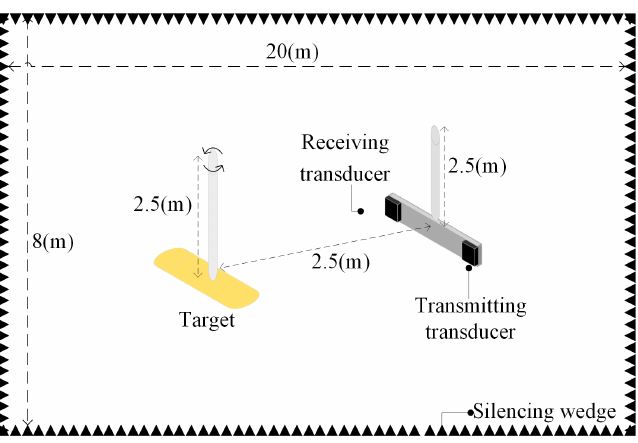
Figure 15. Block diagram of the pool experiment